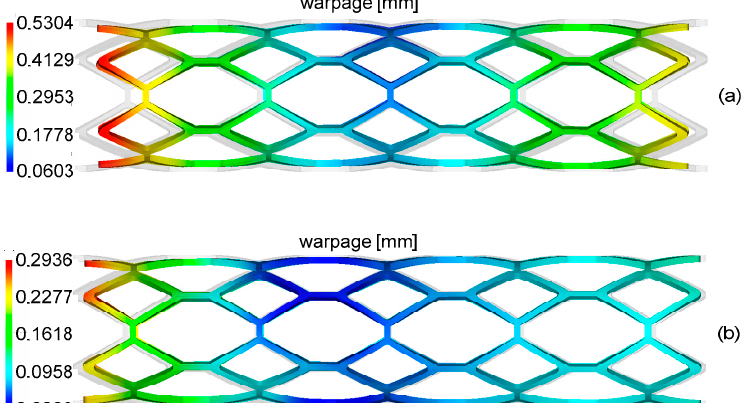
Figure 9. The distribution of warpage of the comparable design and optimal design. ( a ) The distribution of warpage of the comparable design; ( b ) The distribution of warpage of the optimal design.